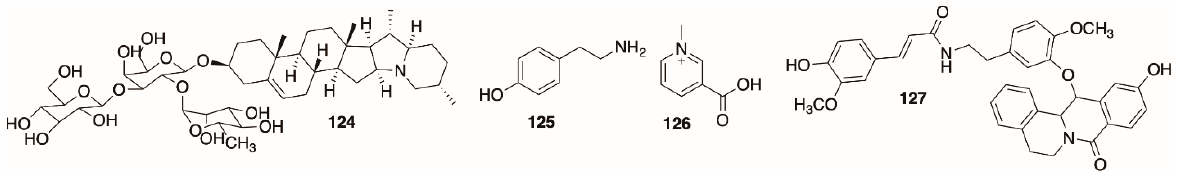
Figure 13. Miscellaneous alkaloids identified in Datura .